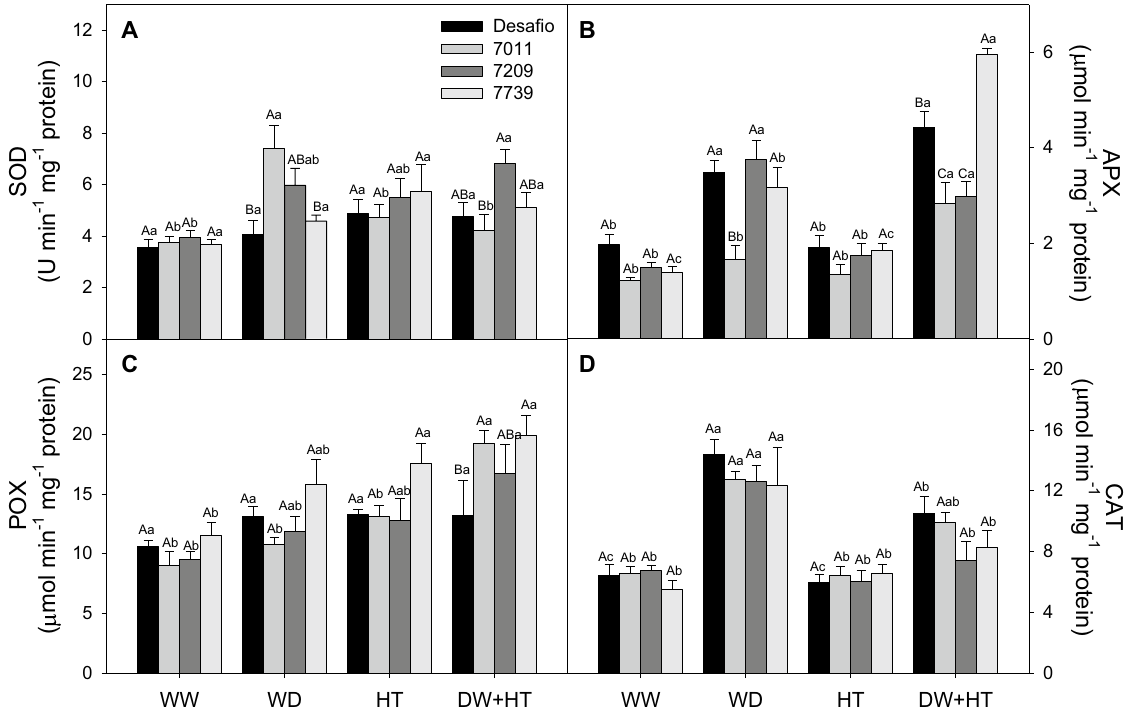
Figure 4. Activity of antioxidant enzymes of soybean plants maintained for 8 days under well-watered (WW; 100% holding water capacity HWC, 25 °C), water deficit (WD; 40% HWC, 25 °C), high temperature (HT; 100% HWC, 40 °C) and water deficit plus high temperature (WD + HT; 40% HWC; 40 °C) conditions. ( A ) Superoxide dismutase (SOD). ( B ) Ascorbate peroxidase (APX). ( C ) Total peroxidase (POX). ( D ) Catalase Bars represent mean ± SE ( n = 5). Means followed by the same uppercase letters compare cultivars within the same water and temperature treatment. Means followed by the same lowercase letters compare water and temperature treatments within the same cultivar, as determined by the Tukey test at 5% of